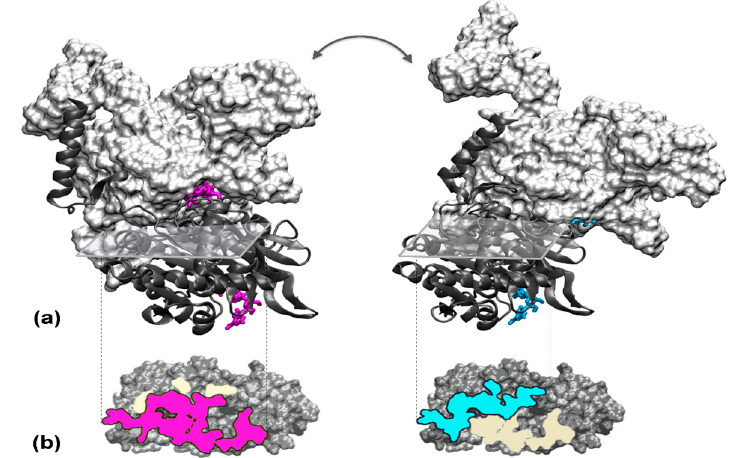
Figure 3. Cofactor-dependent RecA-RecA interface changes. ( a ) Two interacting RecA monomers are represented in the presence of ATP (left) or ADP (right). In both views, the top monomer is in surface mode, colored white, and the bottom monomer is in cartoon mode, colored dark grey. The ATP and ADP molecules are represented in licorice, respectively, in magenta and cyan. The bottom monomers are represented in the same orientation. ( b ) Projection of the ATP (left, interface in magenta) and ADP interface (right, interface in cyan) on the surface of the bottom monomer. In both views, the regions that are present in the other interface are in light yellow. Although the two interfaces overlap, amino acids that are present in both interfaces interact with different amino acids in the opposite partner.